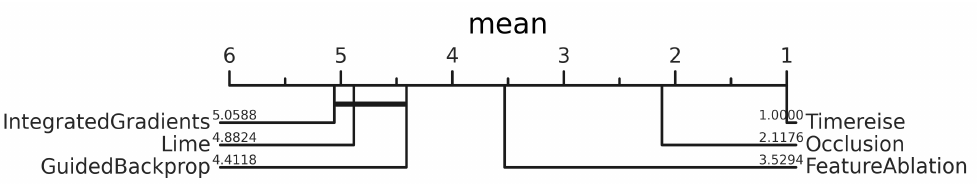
Figure 9. Continuity. Critical difference diagram showing the average rank of each attribution method across all datasets. The ranking is based on the average Continuity. PErturbation-based approaches show superior performance.The horizontal bars show the groups that can be concluded based on the rank of the methods. They clearly highlight the low performing